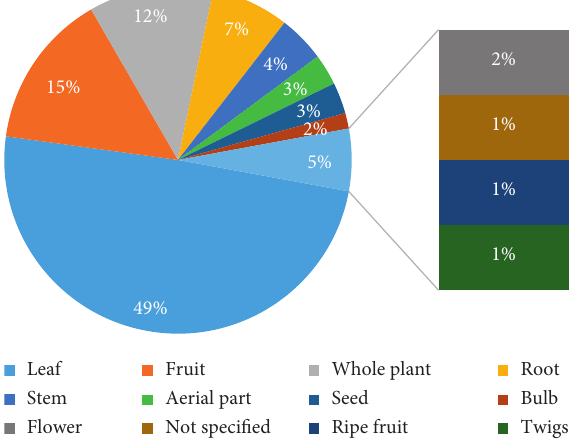
Figure 1: Frequencies of parts